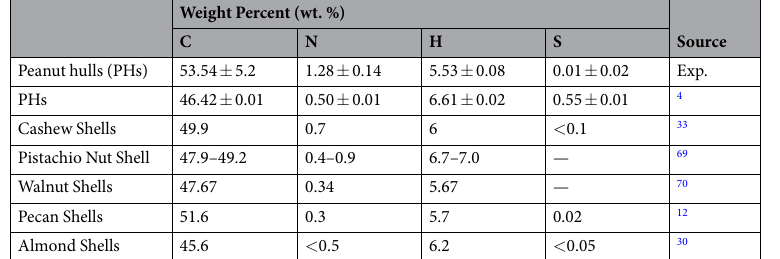
Table 2. Elemental compositions of nut shells.